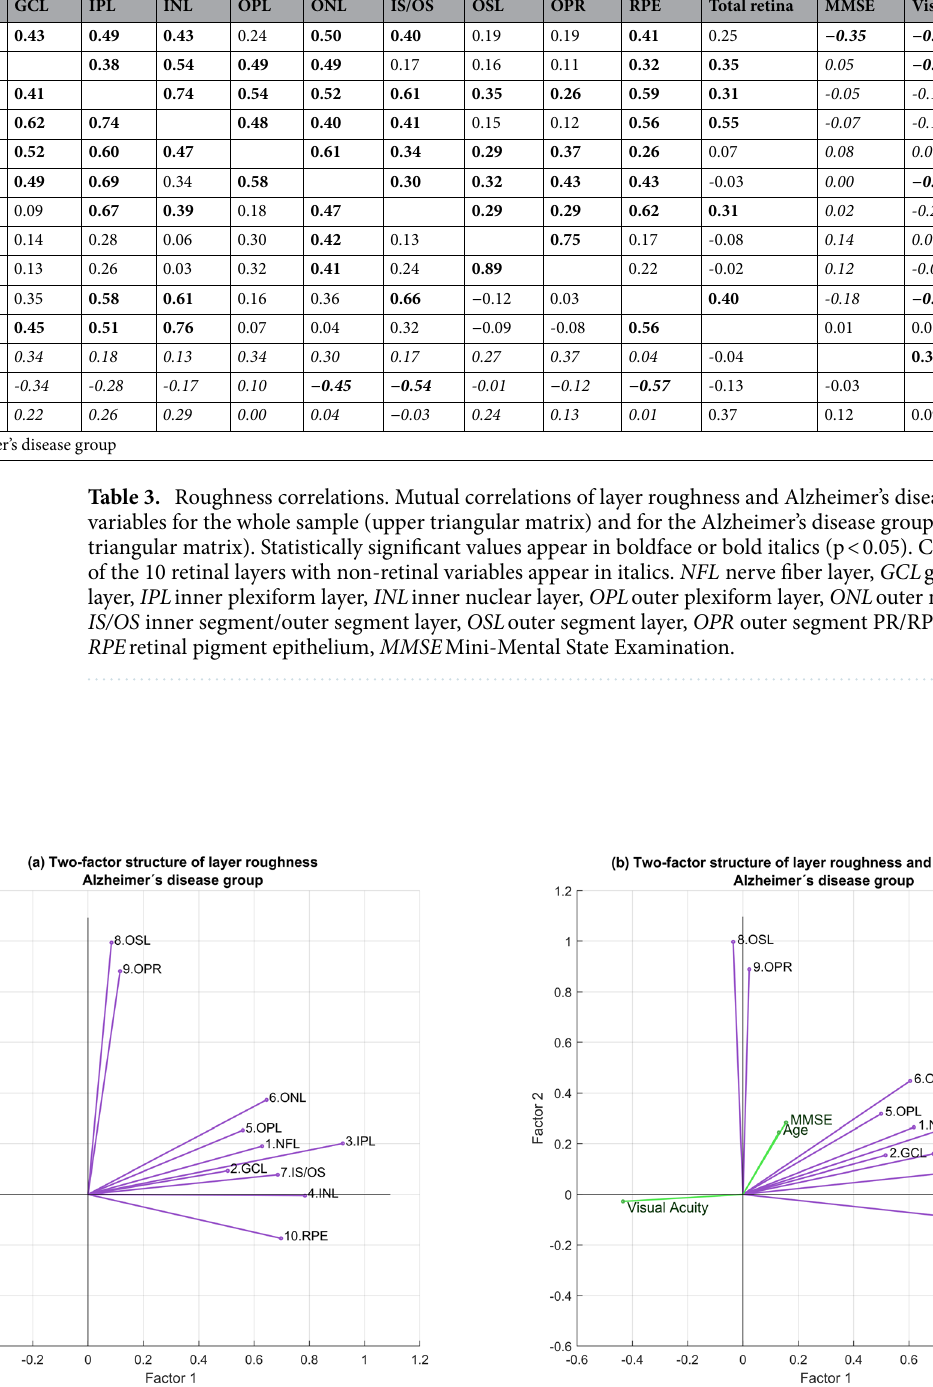
Figure 4. Two-factor structure of retinal roughness. Each vector represents the fractal dimension of a retinal layer; the lower the angle between two vectors, the stronger the correlation between the fractal dimensions of the corresponding layers. (a) The two nearly perpendicular bouquets of vectors suggest that layer roughness might be affected by two independent factors -represented by the two coordinate axes- each one acting mainly on the layers corresponding to its bouquet. (b) When MMSE, visual acuity and age are included in the factor analysis, only visual acuity shows a relevant and negative relationship with the factor linked to the vector subset headed by inner plexiform layer. The data led to the identification of the two independent factors as the beginning of the retinal inflammatory process (factor 1) and the dysregulation of the choroidal vascular network (factor 2). NFL nerve fiber layer, GCL ganglion cell layer, IPL inner plexiform layer, INL inner nuclear layer, OPL outer plexiform layer, ONL outer nuclear layer, IS/OS inner segment/outer segment layer, OSL outer segment layer, OPR outer segment PR/RPE complex, RPE retinal pigment epithelium, MMSE Mini-Mental State